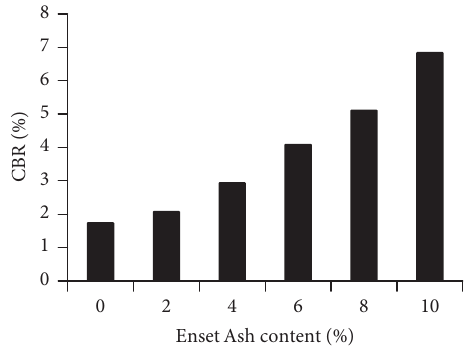
Figure 4: Variation of CBR value with a percentage of Enset ash (EA)